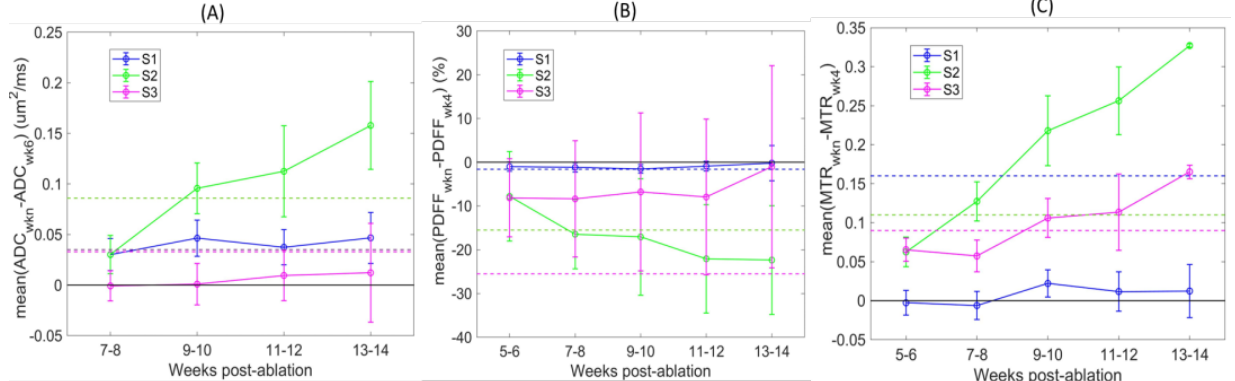
Figure 4. QIB changes with respect to initial BL imaging points (post-ablation week 4 for MTR and PDFF, and week 6 for ADC) for individual animals are plotted for ADC ( A ), PDFF ( B ), and MTR ( C ). Symbols and error bars mark, respectively, the average QIB change and its standard deviation across animals. The tibia bone-marrow section assignments are color-coded in the legend. The solid lines connect symbols to illustrate the trends, and the dashed horizontal lines mark the 95% confidence threshold for the corresponding QIB changes (determined by RC in Table 1).